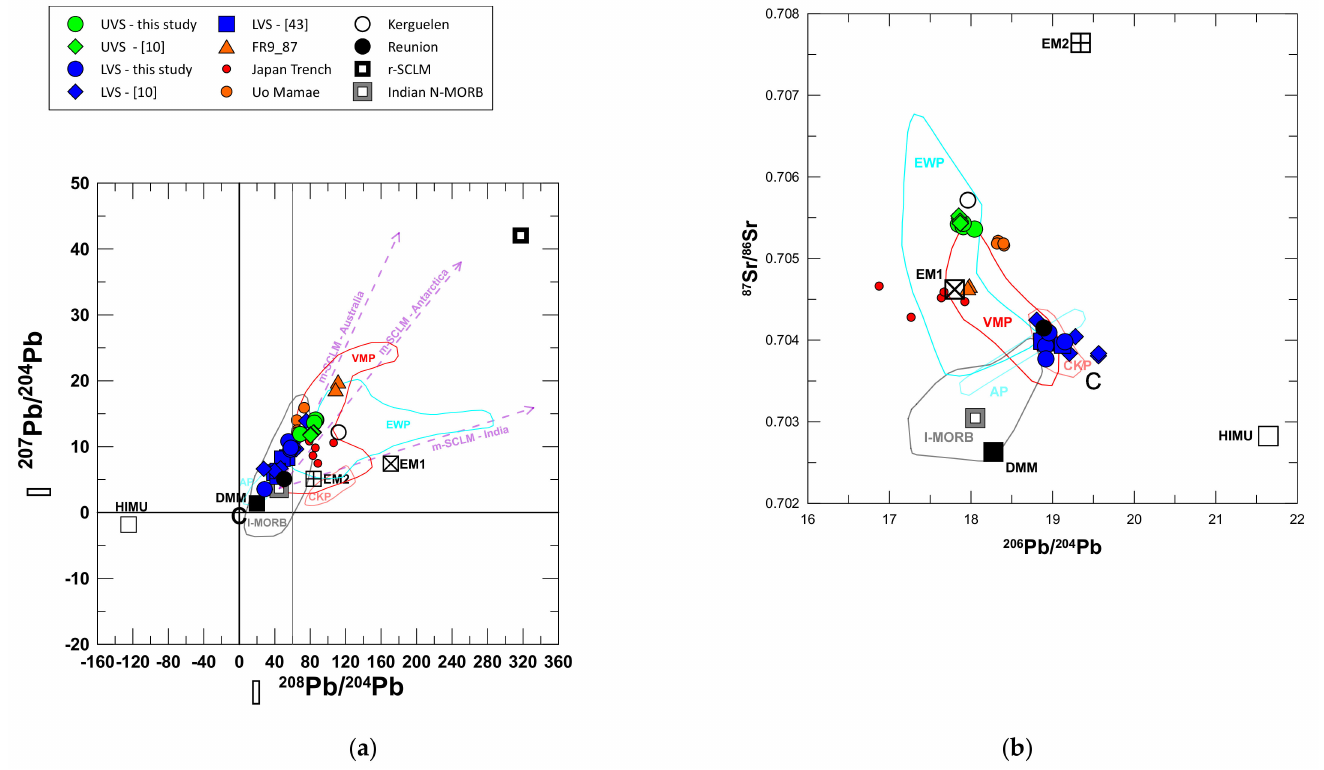
Figure 11. ( a ) ∆ 208 Pb/ 204 Pb versus ∆ 207 Pb/ 204 Pb [36] and ( b ) 87 Sr/ 86 Sr versus 206 Pb/ 204 Pb for